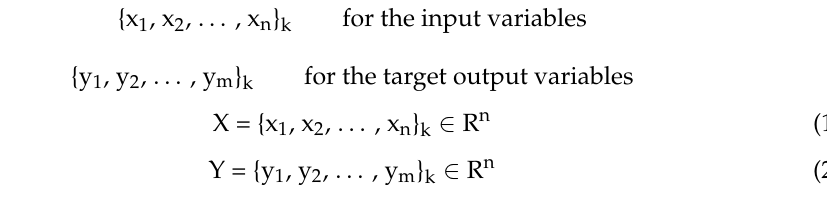
Figure 1. Dynamic Control System for the PEVs.